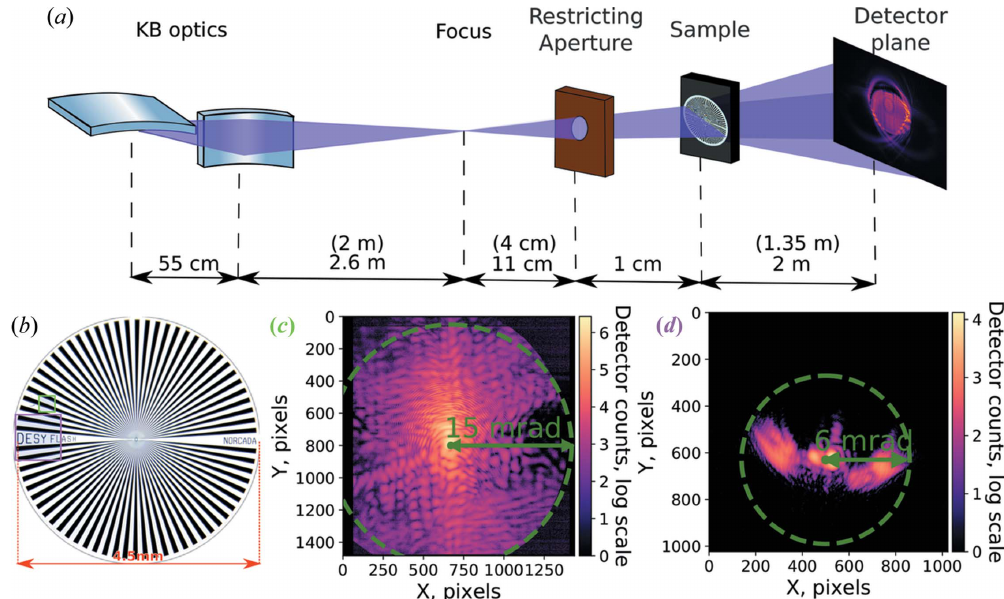
Figure 2 ( a ) Schematic outline of the experimental setup used for the experiment described by Kharitonov et al. (2021). The FEL beam was focused using KB mirrors, thus creating a divergent probe geometry. A restricting aperture was used to limit spatial fluctuations. The sample was placed after the focus. Values in brackets correspond to the setup used with the PERCIVAL detector in 2020. ( b ) Optical microscopy image of the sample. Two scanned areas, one highlighted in a magenta square and one in green, were used. The magenta area indicates non-symmetric structure made up of letters and the green area bright and dark lines that radiate from a common center. Comparison of typical diffraction patterns measured with ( c ) the PERCIVAL detector and ( d ) the CCD camera reported by Kharitonov et al. (2021). Photons with approximately two orders of magnitude intensity and higher diffraction angles were captured with the PERCIVAL detector compared with the typical measurements in ( d ). Achieving the same dynamical range in ( d ) demands an increase in intensity and, consequently, a beamstop. The green scales in ( c ) and ( d ) show the maximum measured angle of diffraction in Fourier ( q ) space.